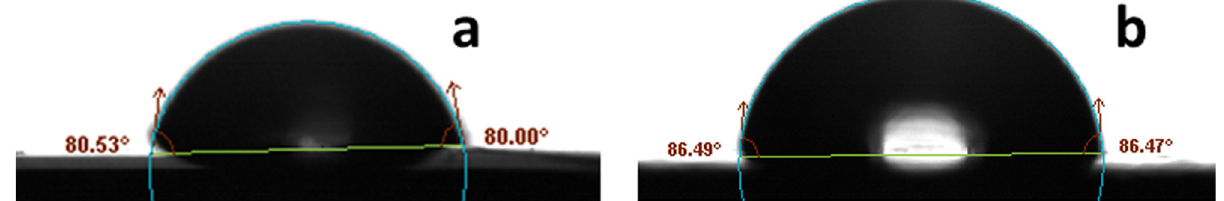
Figure 6: Hydrophobicity evaluation of ROHA ( a ) and ROHA/SNP nanocomposite ( b ) by contact angle